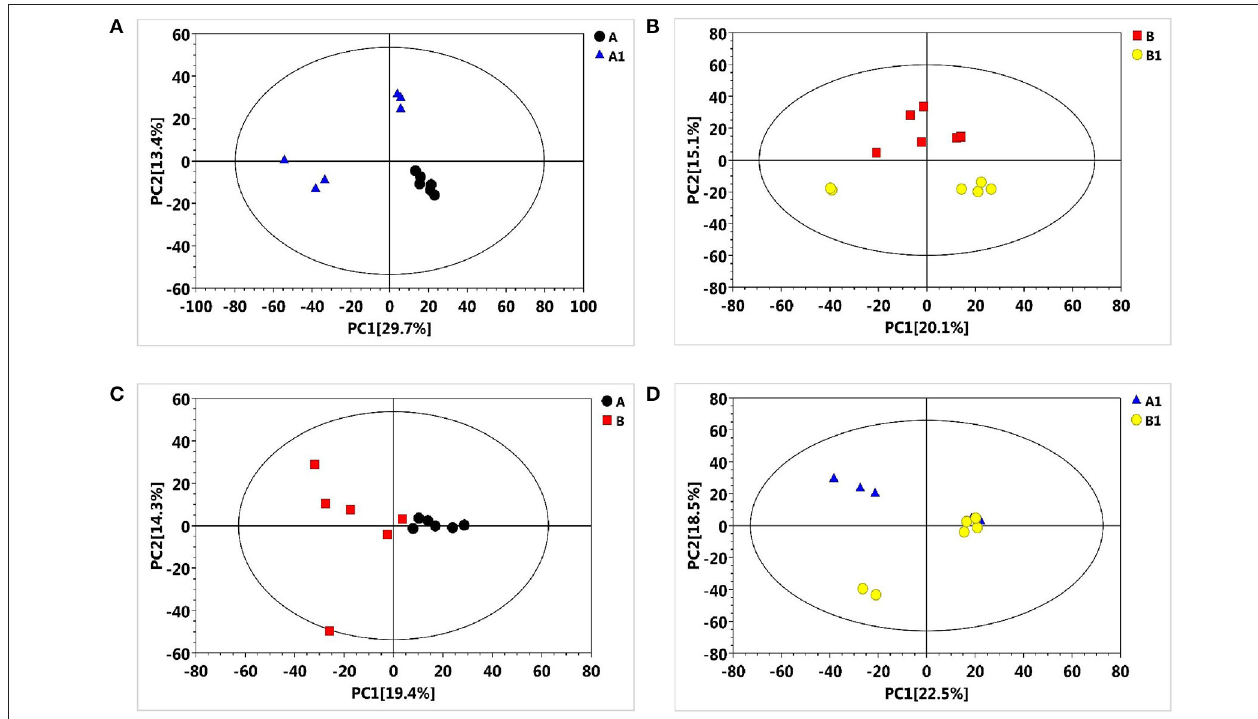
FIGURE 3 | Principal component analysis (PCA) score plots of metabolic profiles in alfalfa roots under the alkali stress. (A) PCA score plot for NI control (black), NI alkali-treated (blue) samples, (B) PCA score plot for RI control (red) and RI alkali-treated (yellow) samples, (C) PCA score plot for NI control (black) and RI control (red) samples, (D) PCA score plot for NI alkali-treated (blue) and RI alkali-treated (yellow) samples.